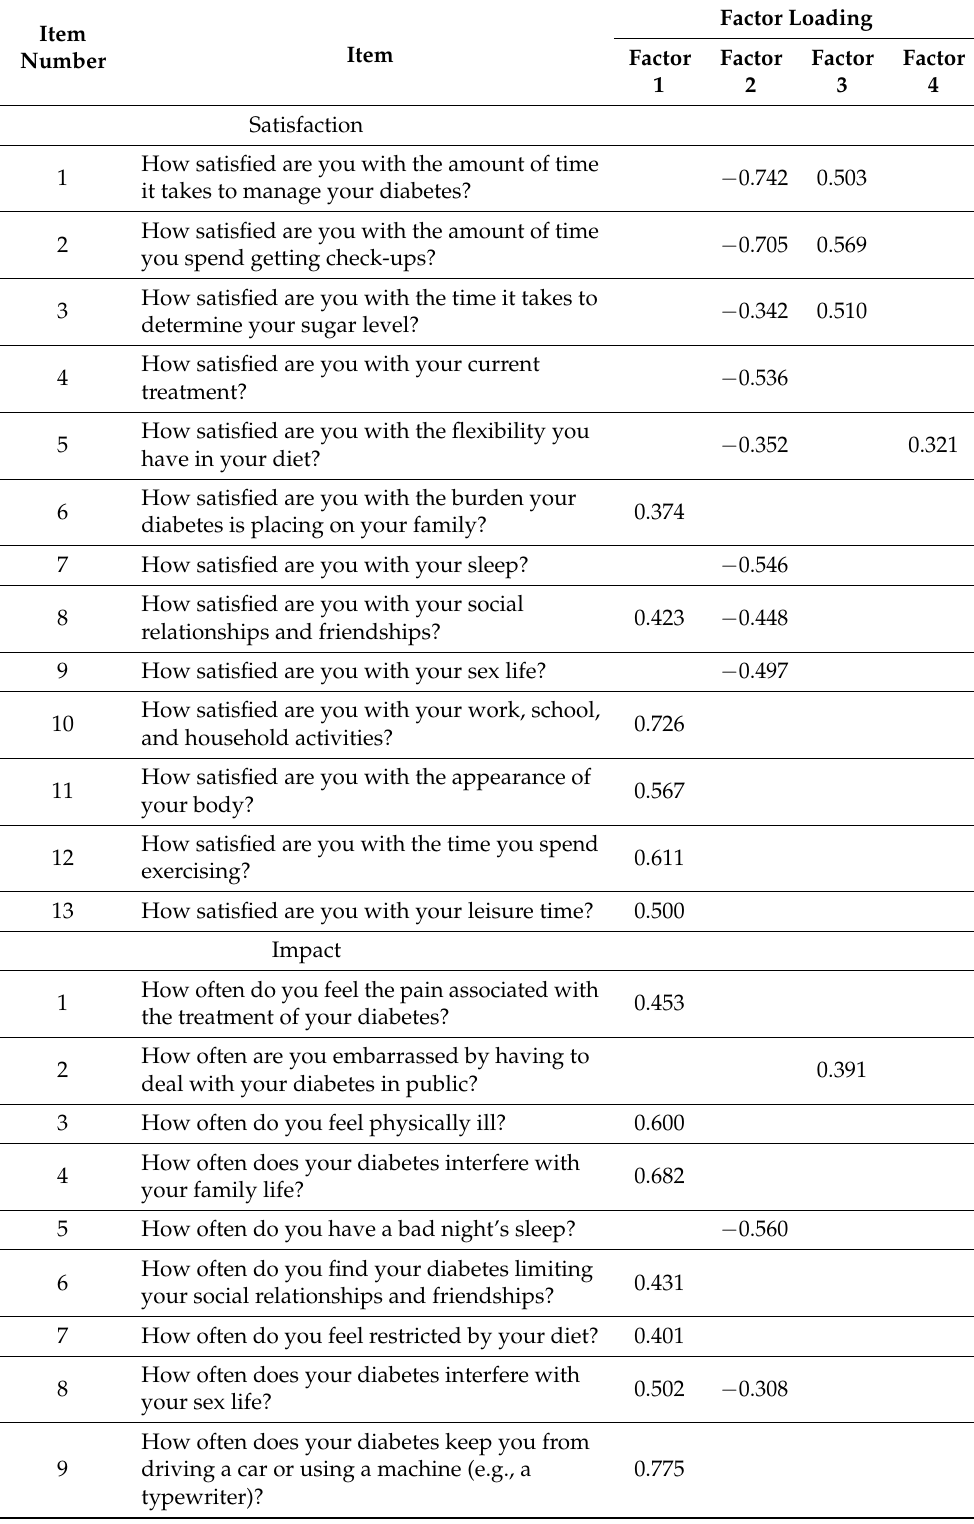
Table 3. Initial EFA results of the DQOL-AO version (in English) among adults living with type 2 diabetes attending Nekemte Specialized Hospital, 2020 ( n =